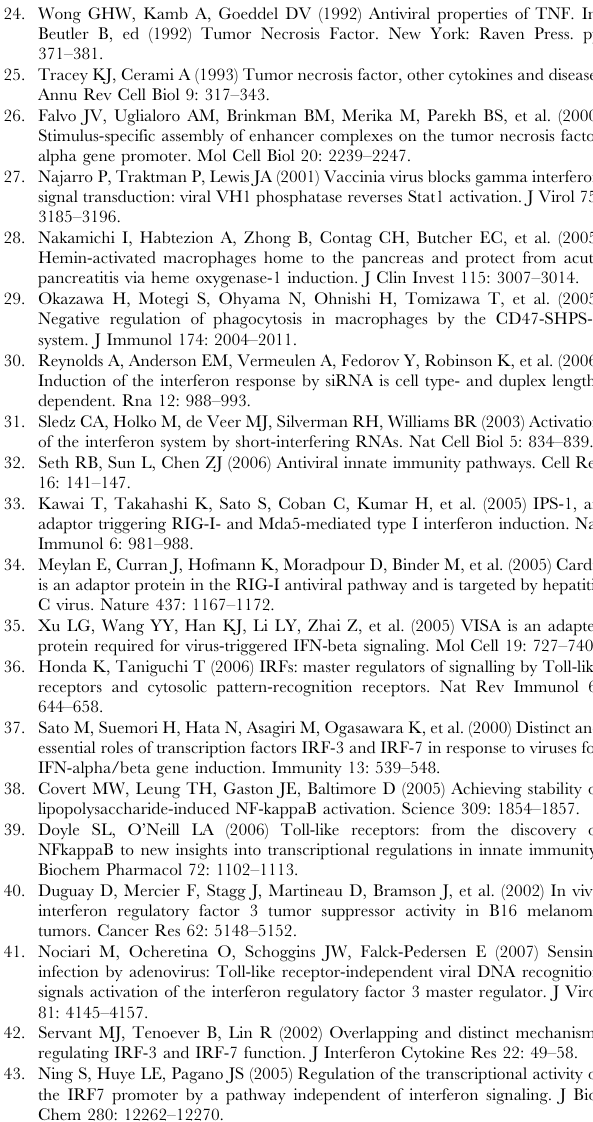
Figure S2 Two pairs of RIG-I siRNA oligos share similar silencing phenotypes in primary human macrophages. (A) pHMs were transfected with control siRNA or RIG-I siRNA-1 or RIG-I siRNA-2 as indicated (top panel). The cells were analyzed 48 h later by RT-PCR for RIG-I mRNA levels. GAPDH was used as control. (B, C) pHMs or various siRNA pHMs as indicated were mock-infected or infected with MV for 24 h and the accumulation of TNF and IFN- b in the culture supernatants was assessed by ELISA. Data in (B) and (C) represent mean + / 2 SD. Figure S3 RIG-I siRNA transfection does not activate nonspe- cific type I IFN response in pHMs. (A) pHMs were mock transfected or transfected with poly(I:C) or with RIG-I siRNA-1 or RIG-I siRNA-2 for 24 h. IFN- b accumulation in the culture supernatants was assessed by ELISA. Data represent mean + /